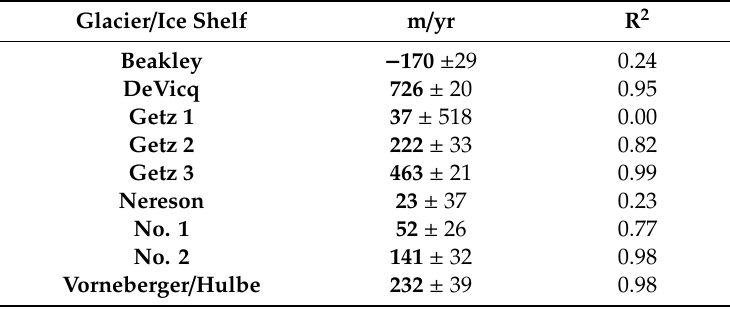
Table 5. Glacier change rates per year with mean standard deviation from Table 4 and R-square of the linear